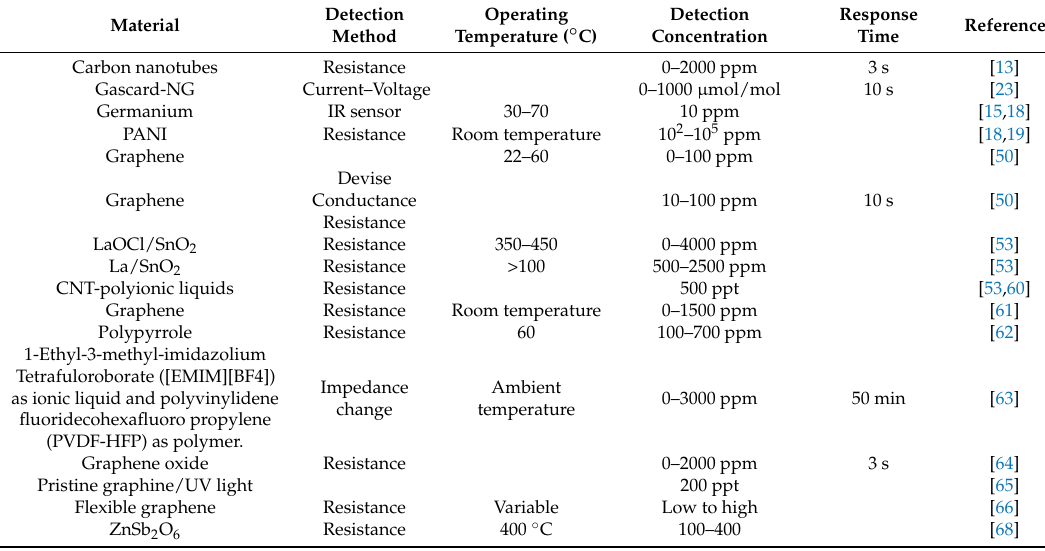
Figure 19. ( a ) CO 2 sensor with metal oxide-zeolitic imidazole framework on the optical fiber. Reproduced with permission from Reference [69]. ( b ) Performance characteristics of CO 2 sensor giving percentage transmission and absorbance features. MOF: Metal organic framework. Reproduced with permission from Reference [69]. Table 3. Carbon dioxide sensing materials.